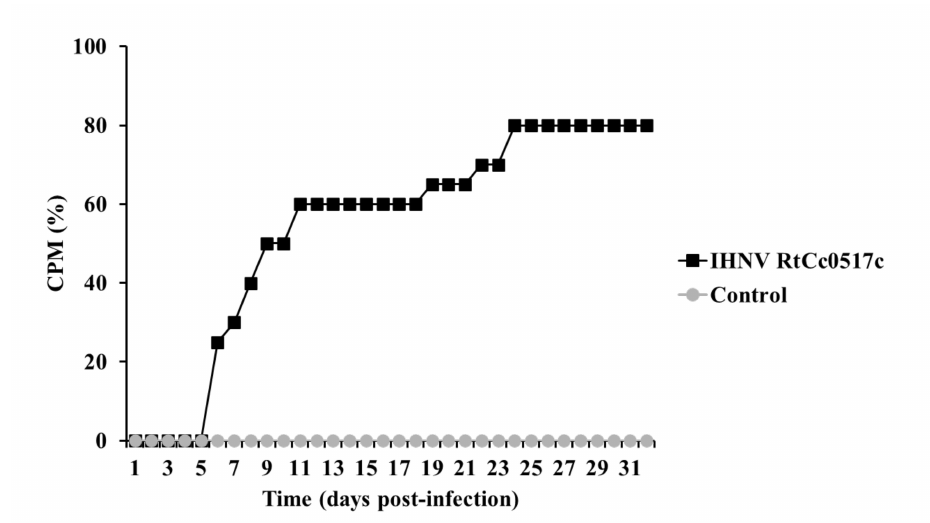
Figure 1. Cumulative percent mortality (CPM) of rainbow trout challenged by